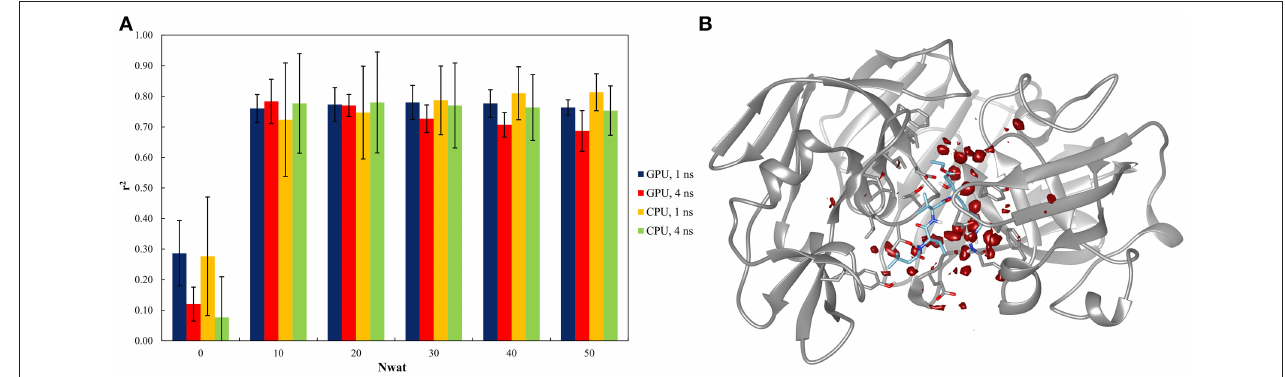
FIGURE 2 | Results of the penicillopepsin system regarding the application of Nwat-MMGBSA method. (A) Bar chart of r 2 in dependency at different Nwat and computational conditions. Nwat = 0 corresponds to a standard MM-GBSA calculation. (B) Water density plot obtained by grid analysis of penicillopepsin-1APT complex (visualization with Chimera, step = 1, level =